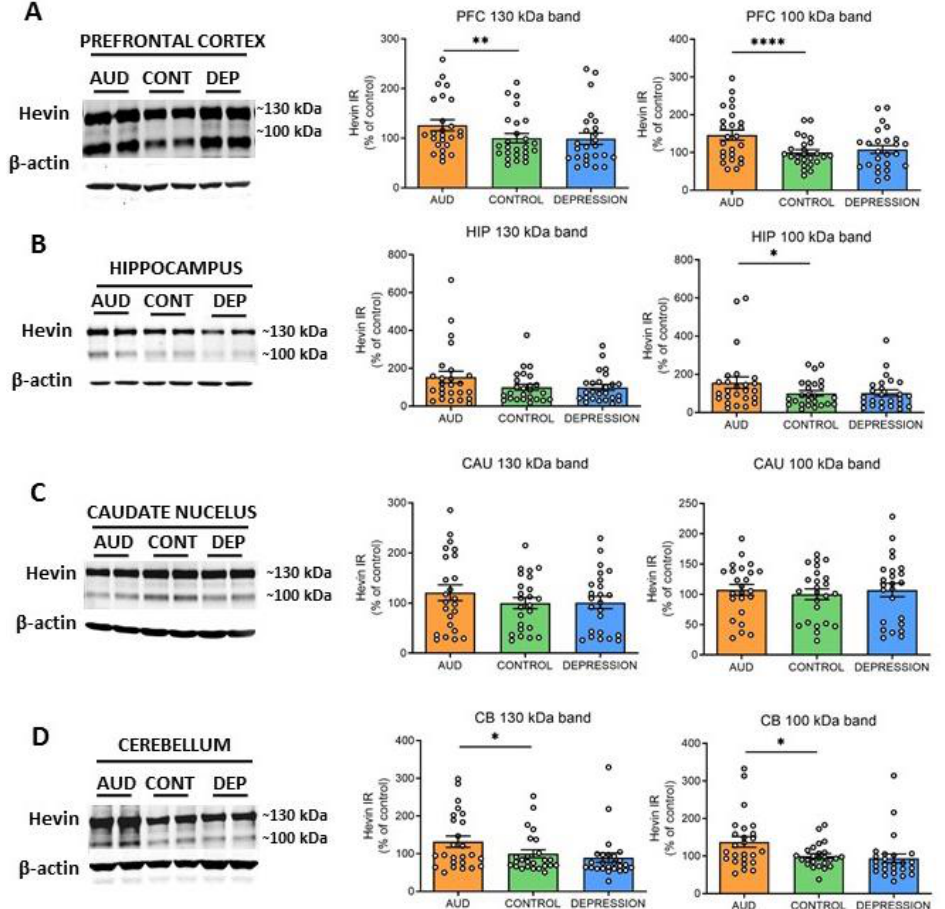
Figure 2. Protein expression of hevin in postmortem human brains of alcohol use disorder (AUD) subjects. Hevin protein expression in postmortem brain samples from subjects with AUD, depression (DEP) and controls (CONT) in the prefrontal cortex (PFC) ( A ), hippocampus (HIP) ( B ), caudate nucleus (CAU) ( C ) and cerebellum (CB) ( D ). Representative Western blot images for each brain region are shown, along with the graphics representing the actin-normalized immunoreactivity (IR) of both the ~130 kDa and ~100 kDa hevin bands. n = 25 per group. One-way ANOVA followed by Dunnett’s post-hoc test, * p < 0.05, ** p < 0.01, **** p < 0.0001. Experiments were performed in triplicate. Bars show mean ± SEM, dots represent the average value of each